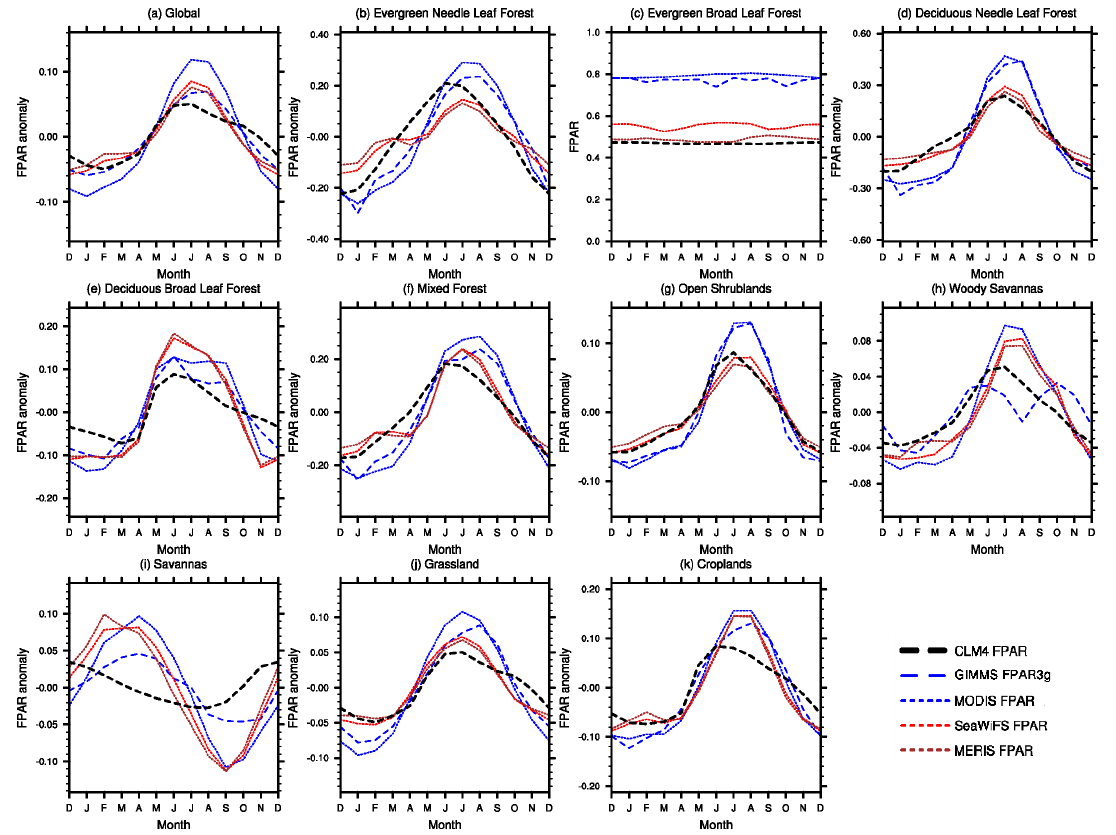
Figure 4. Comparison of 2003 to 2005 averaged seasonal cycle of FPAR anomalies between remote sensing and CLM4 FPAR at ( a ) global level and at biome level: ( b ) evergreen needleleaf forest, ( c ) Evergreen broadleaf forest is compared based on FPAR absolute value due to its special seasonality, ( d ) deciduous needleleaf forest, ( e ) deciduous broadleaf forest, ( f ) mixed forests, ( g ) open shrublands, ( h ) woody savannas, ( i ) savannas, ( j ) grassland, ( k ) croplands.